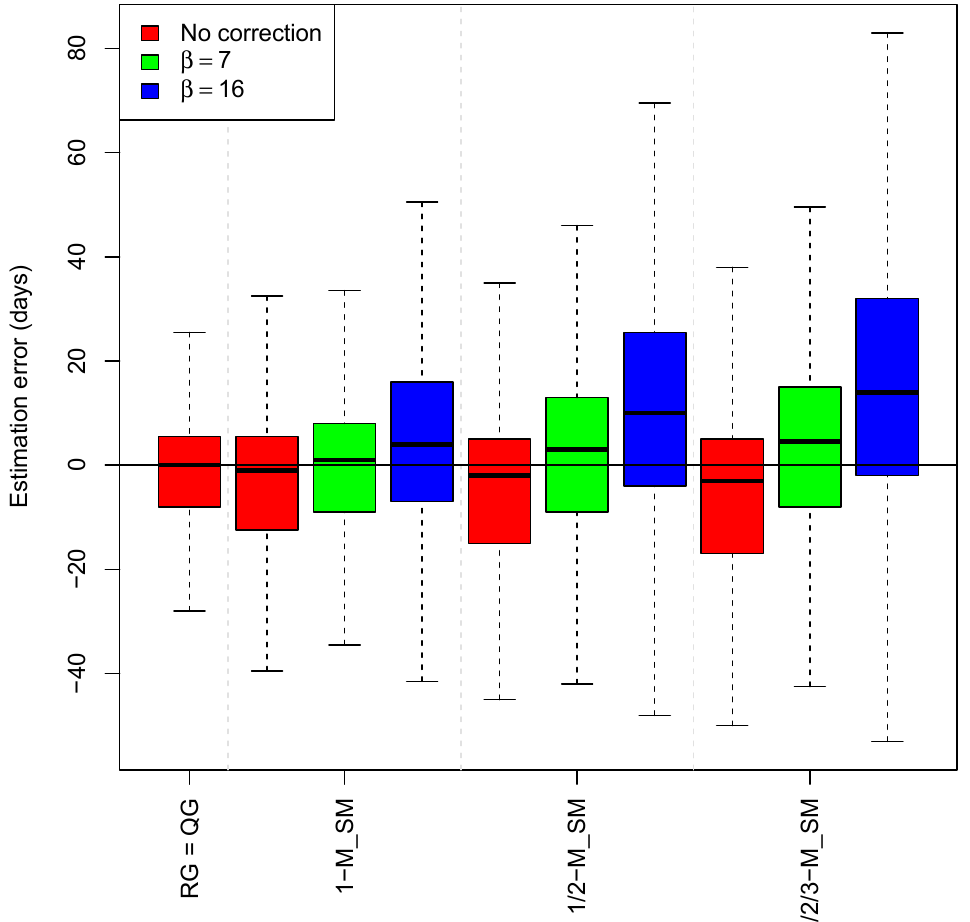
Figure 4. Timeframes (median values for the time of a QG ( t E-QG ) and interquartile ranges) for QGs in mixed phylogenetic models. β = time correction by a single substitution; 1-M_SM = RG match or is a 1-step mutational ancestral or derivative from QG, 1/2-M_SM = RG match or is a 1 or 2-step mutational ancestral or derivative from QG; 1/2/3-M_SM = RG match or is a 1, 2 or 3-step mutational ancestral or derivative from QG.